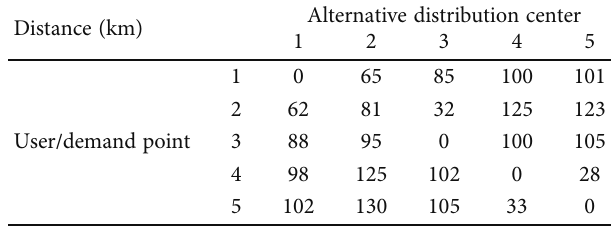
Table 3: Distance from distribution center to users.